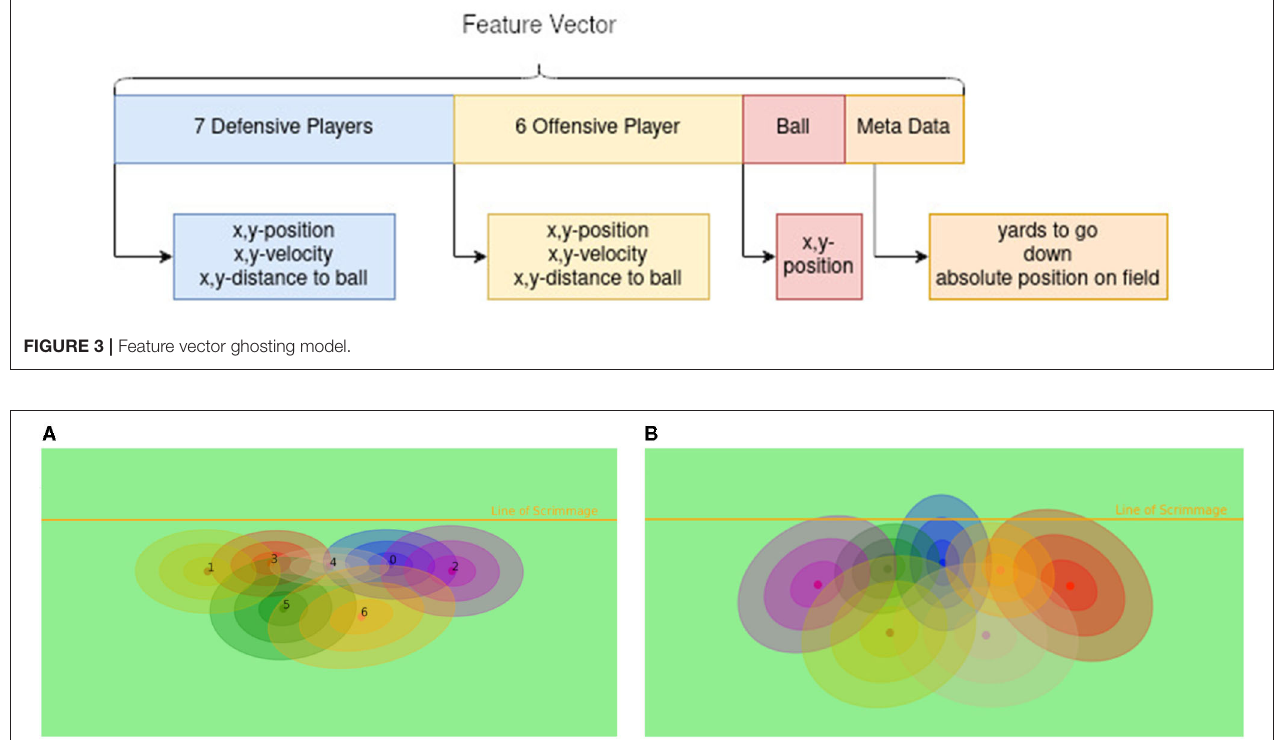
FIGURE 4 | (A) Assignment of specific roles in formations with Gaussian mixture models to the corresponding feature vector. (B) Assignment of roles with a learned Hidden Markov model with Gaussian emission functions for different roles to the specific model according to running positions in the coordinated multi-agent